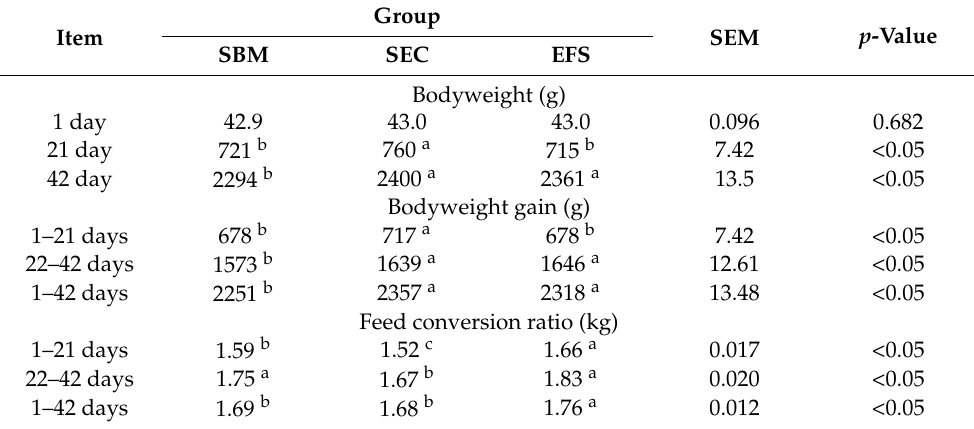
Table 3. Rearing results of broiler